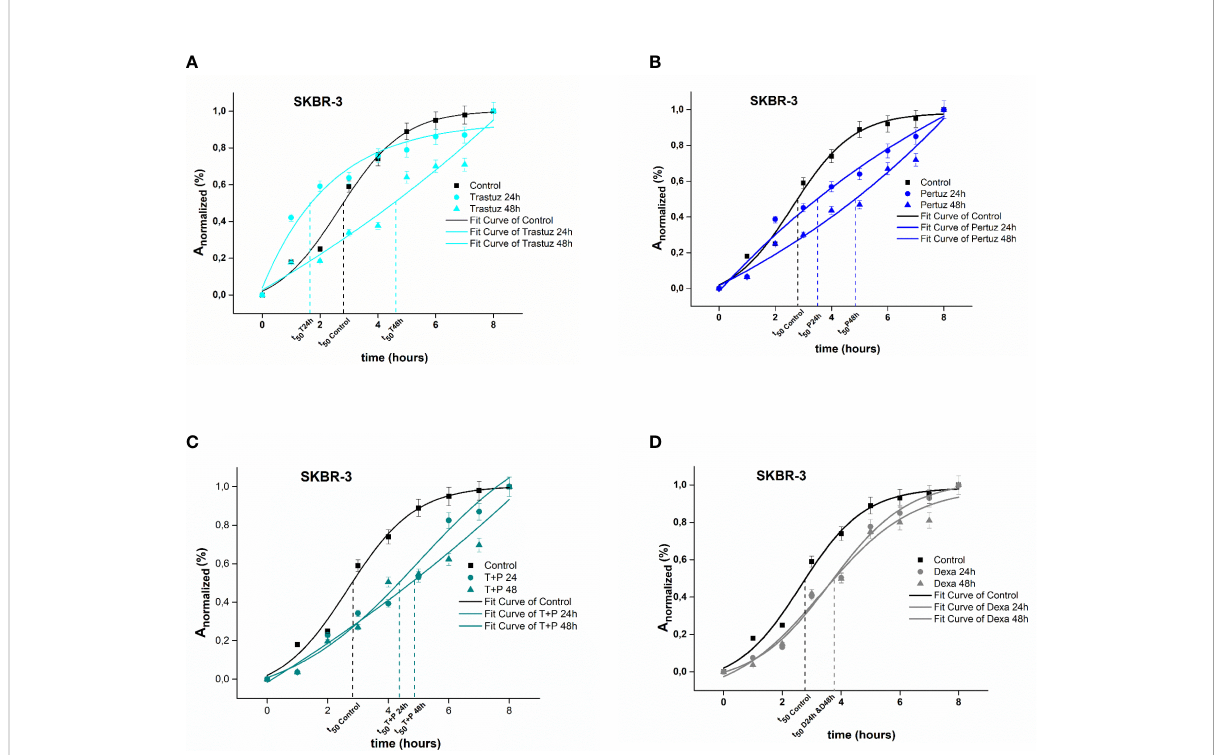
FIGURE 3 Plotted normalized cell area interprets spreading kinetics. Merged experimental curves of three repeated tests of the spreading rate ( dA normalized / dt ) of Control vs trastuzumab (A) , Control vs pertuzumab (B) , Control vs trastuzumab + pertuzumab SKBR-3 (C), and Control vs dexamethasone (D) are